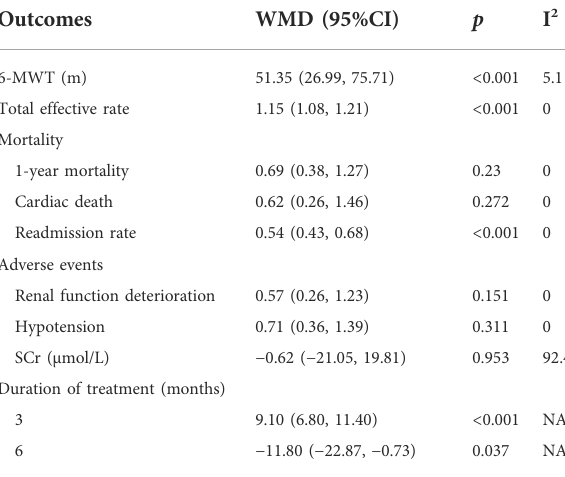
Notes: HFmrEF: heart failurewith mid-range ejection fractions; WMD:weighted mean difference; RR: relative risk; CI: con fi dence interval; LVEF: left ventricular ejection fraction; LVEDD:leftventricular enddiastolic dimension;LVESD: leftventricular end- systolicdiameter;DVST:diastolicventricularseptalthickness;LAD:leftatrialdiameter; SV: stroke volume; FS: left ventricular short axis shortening rate; CRP: C-reactive protein: NT-proBNP: N-terminal-pro brain natriuretic peptide; sST2: soluble suppression of tumorigenesis-2; MHFQL: Minnesota heart failure scale score; KCCQ: The kansas city cardiomyopathy questionnaire; 6-MWT: 6-Minute Walk Test; SCr: serum